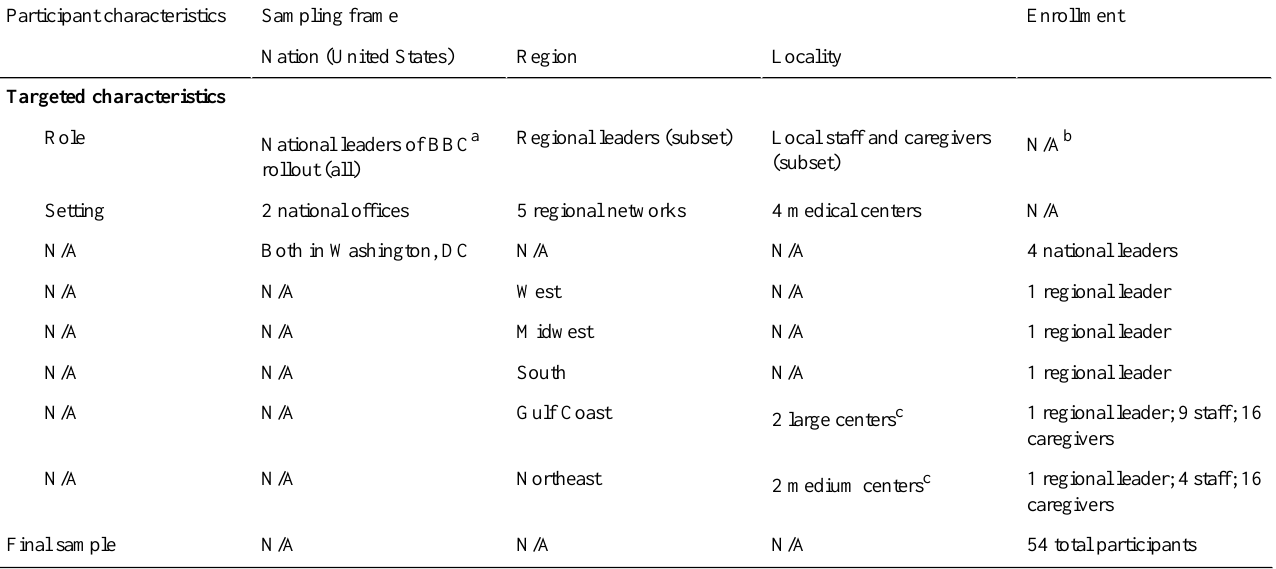
Table 1. Participant sampling frame and subsequent